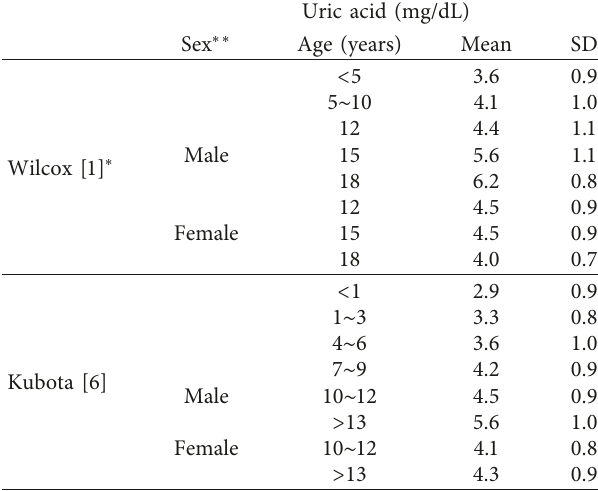
Table 1: Reference values of uric acid in children and